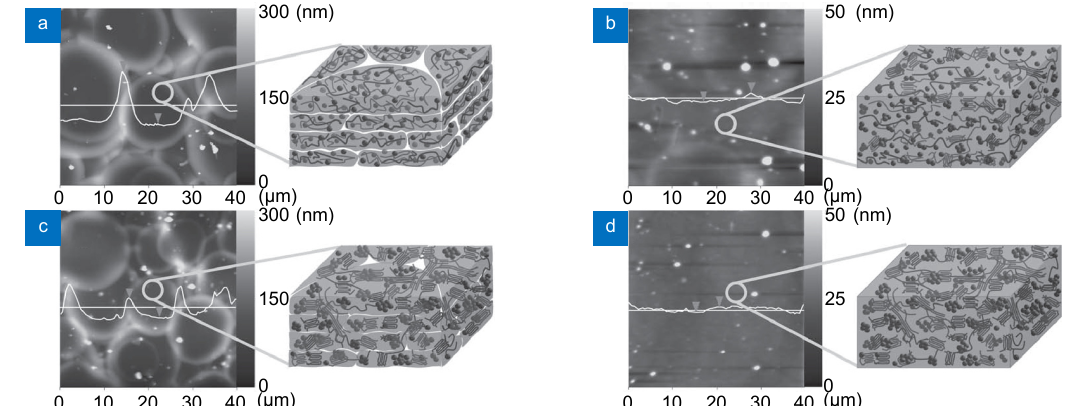
Fig. 5 | AFM images of the electrosprayed P3HT/PCBM-blend films on the PEDOT/PSS-coated ITO/glass . ( a ) As-cast. ( b ) Solvent vapor soaking (SVS). ( c ) Thermal annealing (TA), and ( d ) SVS followed by TA. The white line on the AFM images are the cross-section height. The cartoons are schematic illustrations of the P3HT/PCBM morphologies, depicting the nanoscale phase transition of P3HT (wires) and PCBM (balls) as well as the pancake boundary 44